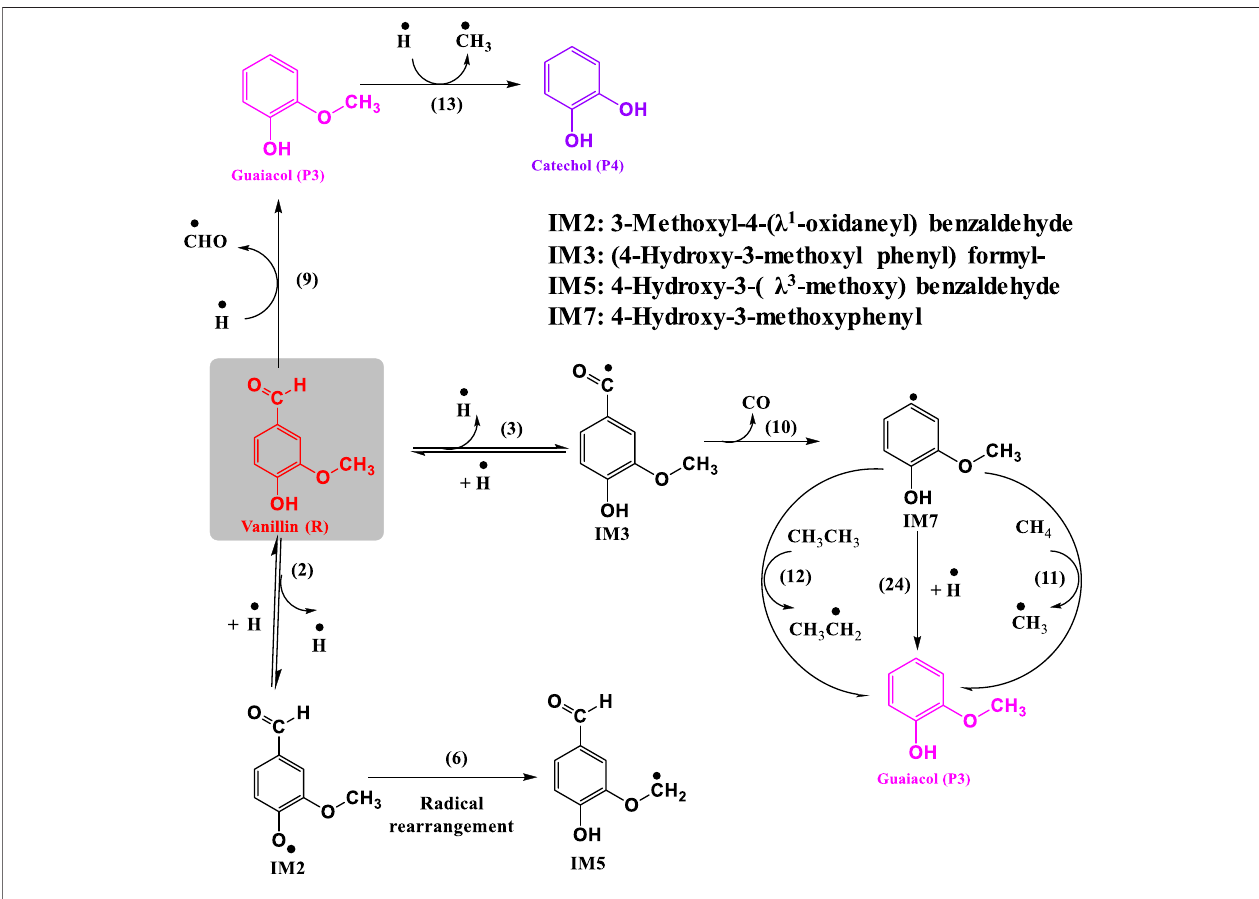
FIGURE 2 | Reaction mechanism of pyrolysis of vanillin to